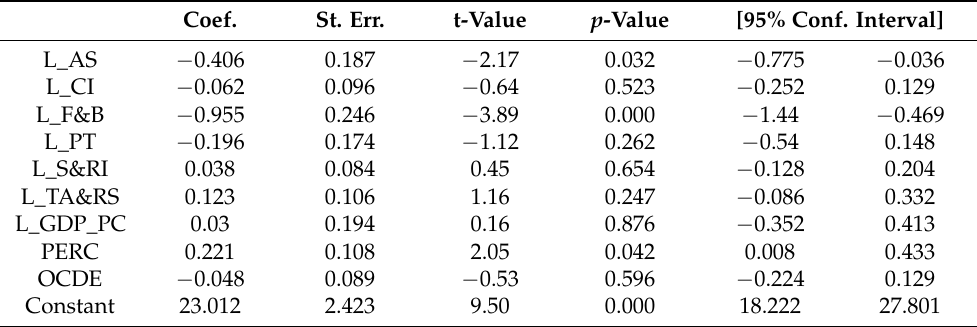
Table A5. Panel data estimations of the explanatory variables of tourism receipts (in logarithm) for the countries in the sample. Fixed effects panel.